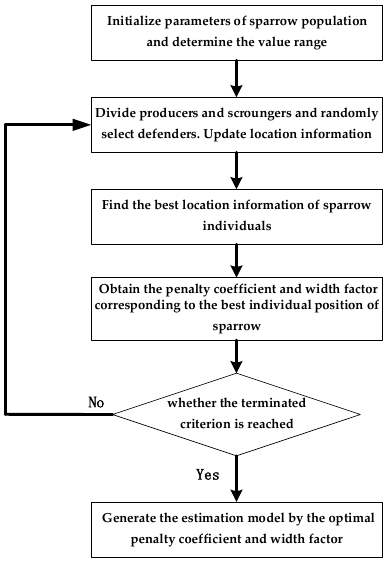
Figure 3. The flowchart of the